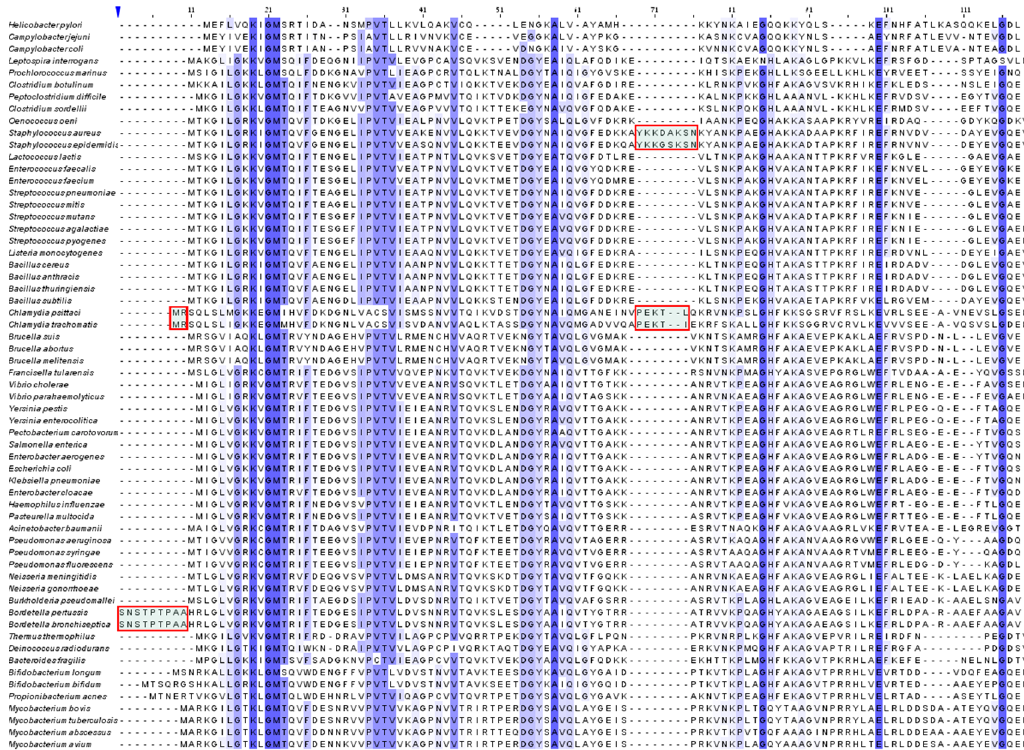
Figure 6. Multiple sequence alignment of protein uL3 from different bacterial species clearly showing its unique additional insertion (framed in red). The conserved sequences are highlighted in purple.